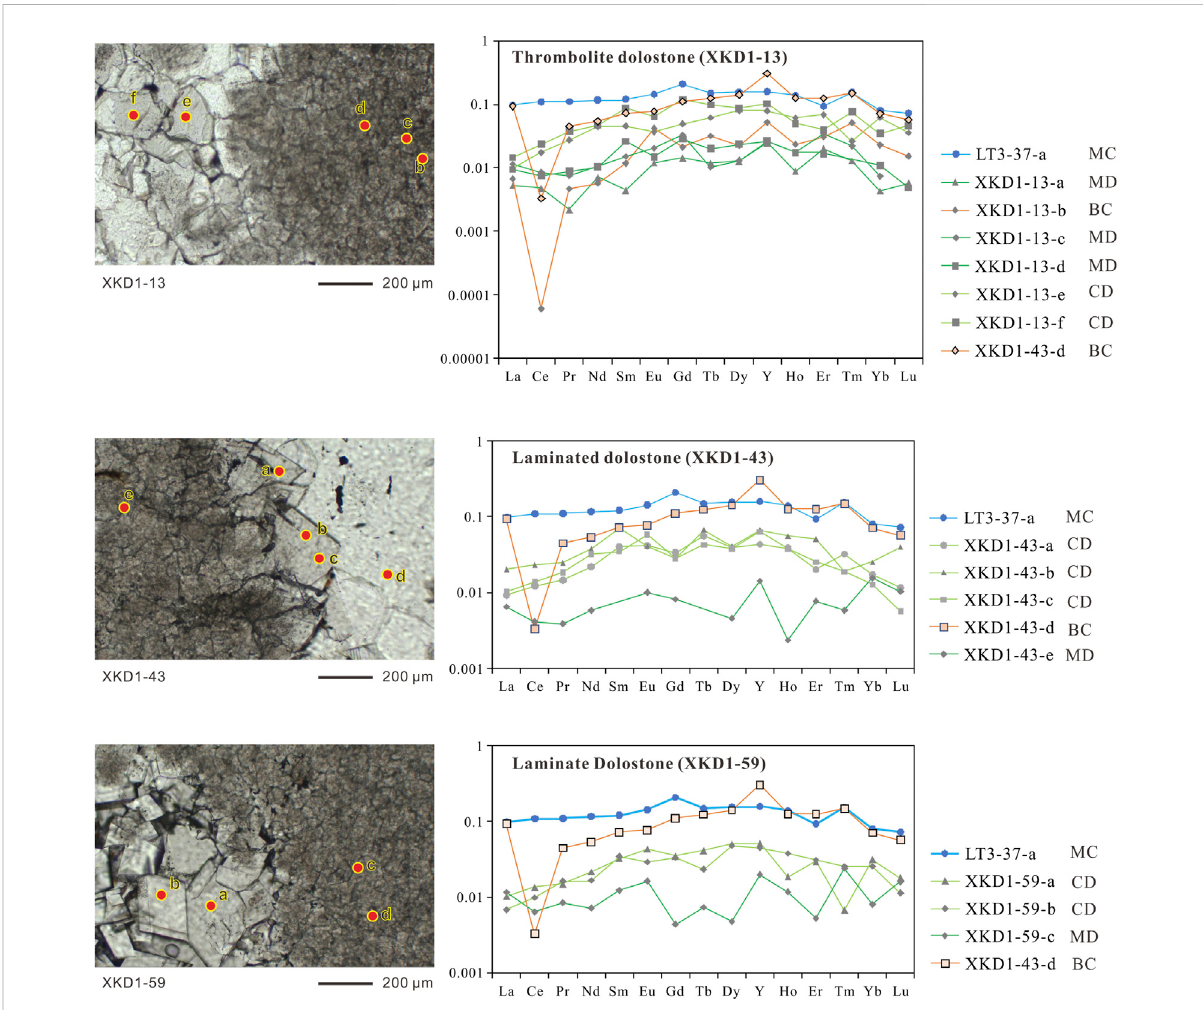
FIGURE 8 The patterns of REE+Y of different types of dolomites (XKD1-13, XKD1-43, and XKD1-59) in the Xiaoerbulake Formation of the well XKD-1.